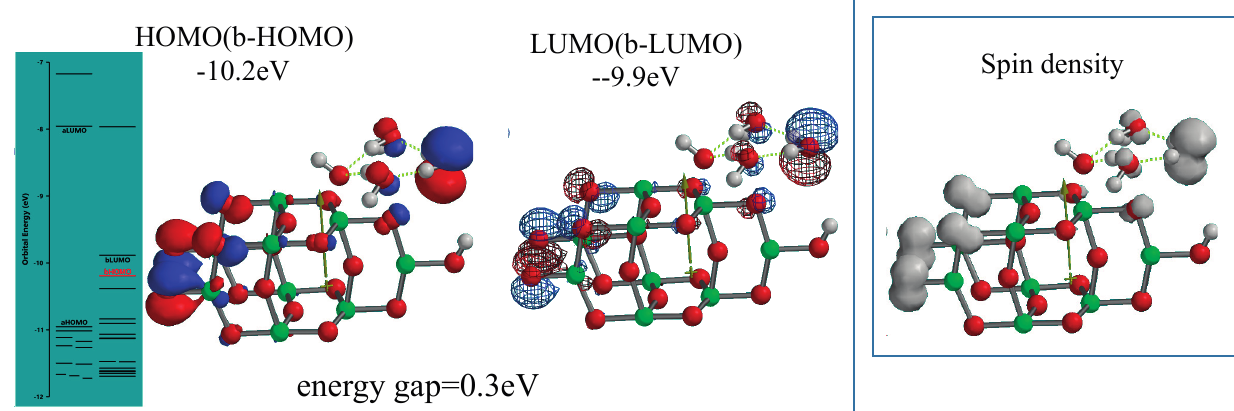
Figure 5. Energy structures of (H 2 O) 3 &[OH(TiO 2 ) 9 H] + as a radical cation model of (H 2 O) 3 -interacted PEC-nc-TiO 2 electrode under UV-irradiated bias conditions of PEC-nc-TiO 2 electrodes, i.e ., a photo-energy-driven operational state